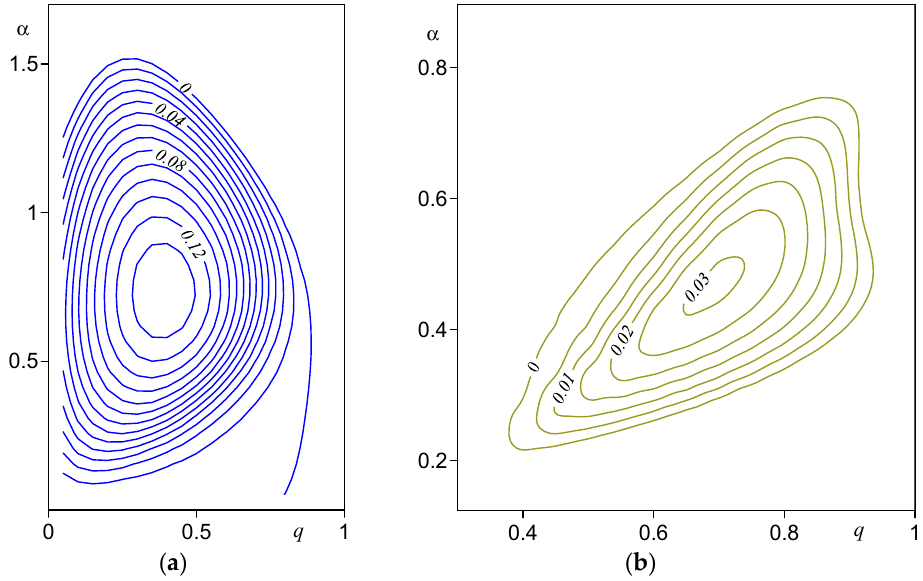
Figure 3. The lines depict the constant growth rate of the values ω i = α c i = const in plane ( α , q ) at Re = 60: ( a ) mode 1; ( b ) mode 2. The outer contour corresponds to the neutral curve on which ω i = 0. The flows are unstable inside it, and one is stable outside it.